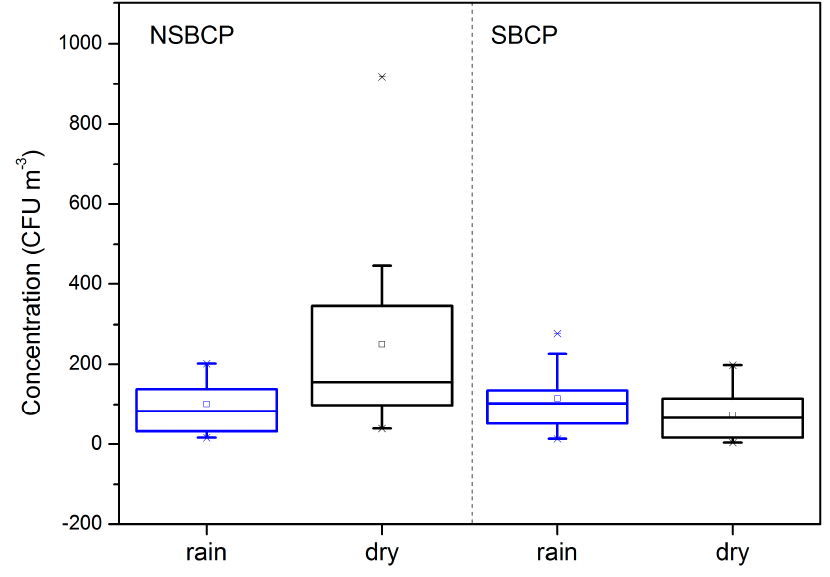
Figure 3. The concentration of NSBCPs and SBCPs during rainy days and dry days.